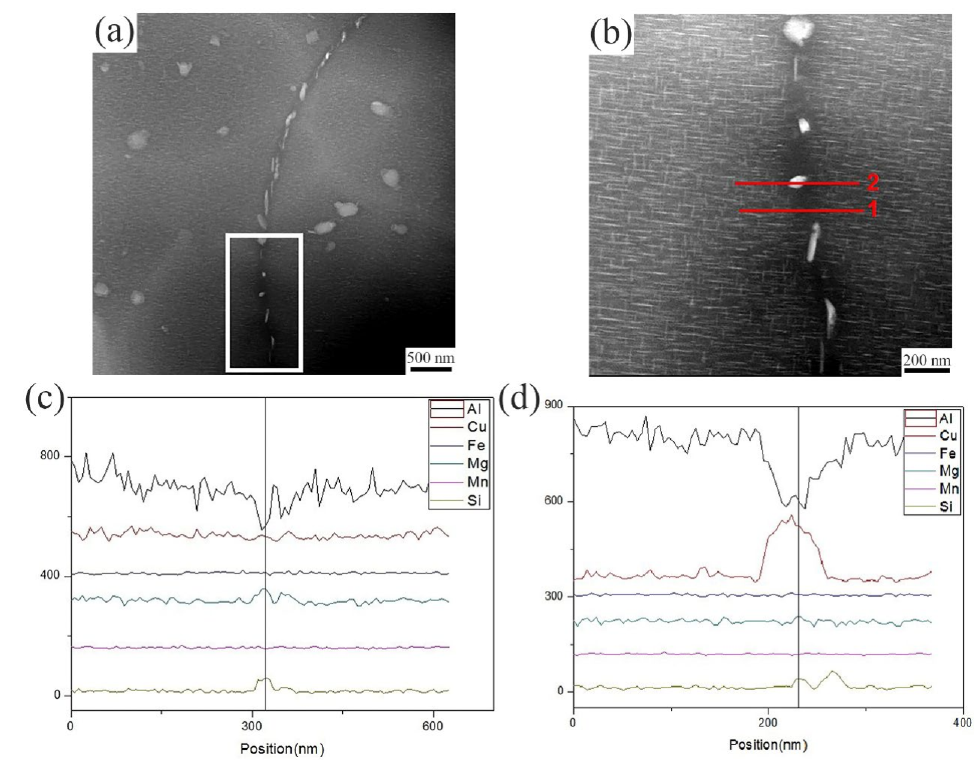
Figure 9. TEM-HAADF images of the grain boundaries and inner-grain precipitates ( a , b , where b is the enlargement of the white square area in a ). The grain boundaries were scanned along the composition lines, shown as red lines 1 ( c ) and 2 ( d ) in ( b